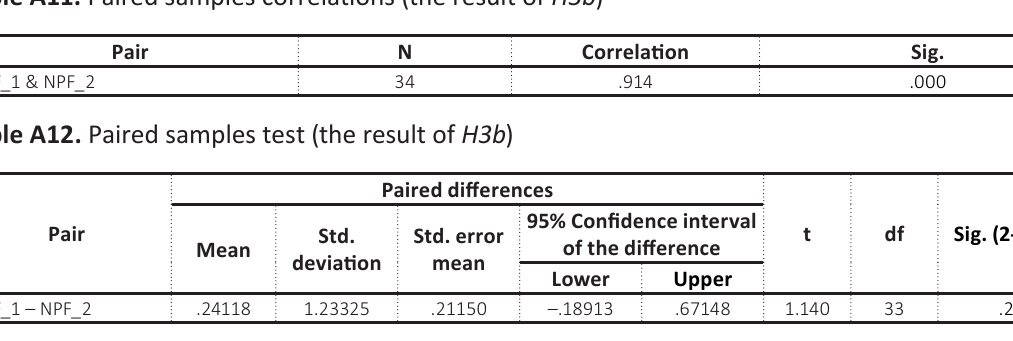
Table A13. Paired samples correlations (the result of H4a ) Pair Sig. Table A14. Paired samples test (the result of H4a )